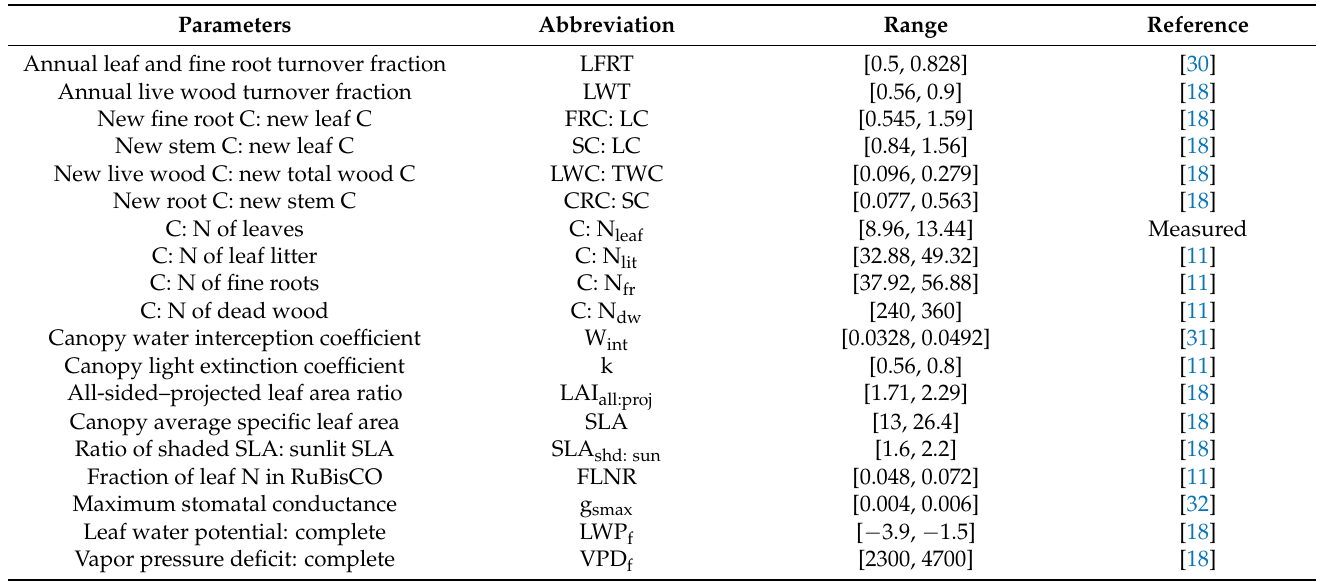
Table 2. Definitions, abbreviations, ranges, and sources of the 19 parameters of the Biome-BGC model used in the sensitivity